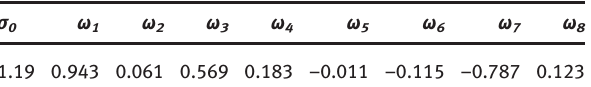
Table 2: The values of σ 0 and ω j obtained by multivariate linear